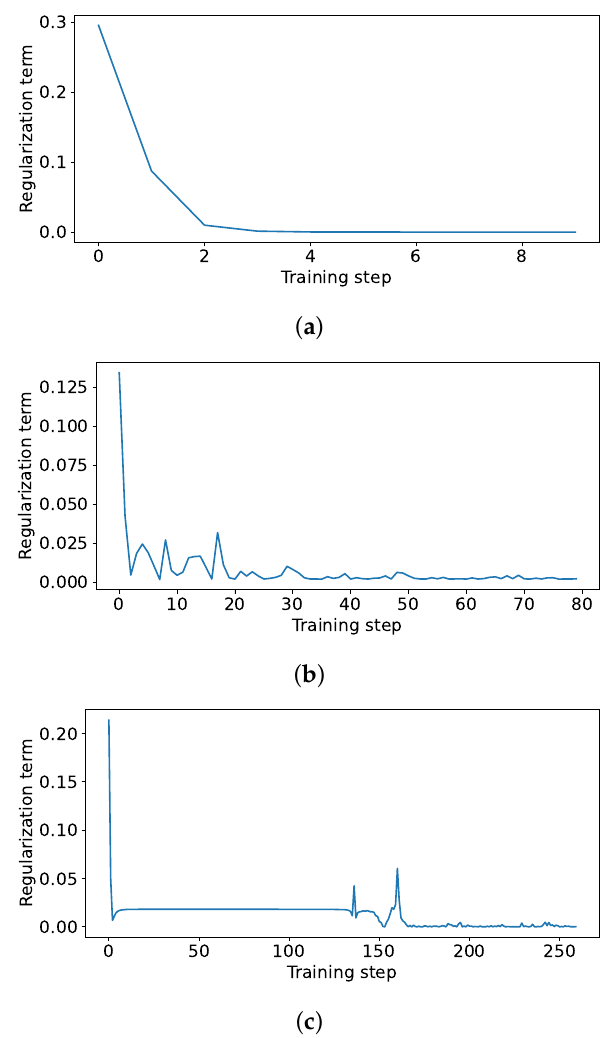
Figure 4. The regularisation term L for three different runs. In ( a ) the regularisation prior π E the extraverted agent coincides with the optimum monetary policy π M and the policy converges within 5 time steps. ( b ) shows a typical training run for the other agents which converges within 100–200 training steps. ( c ) shows a training run where the regularisation term appears to fall in local minimum for a time, but eventually finds the optimum after about 200 training